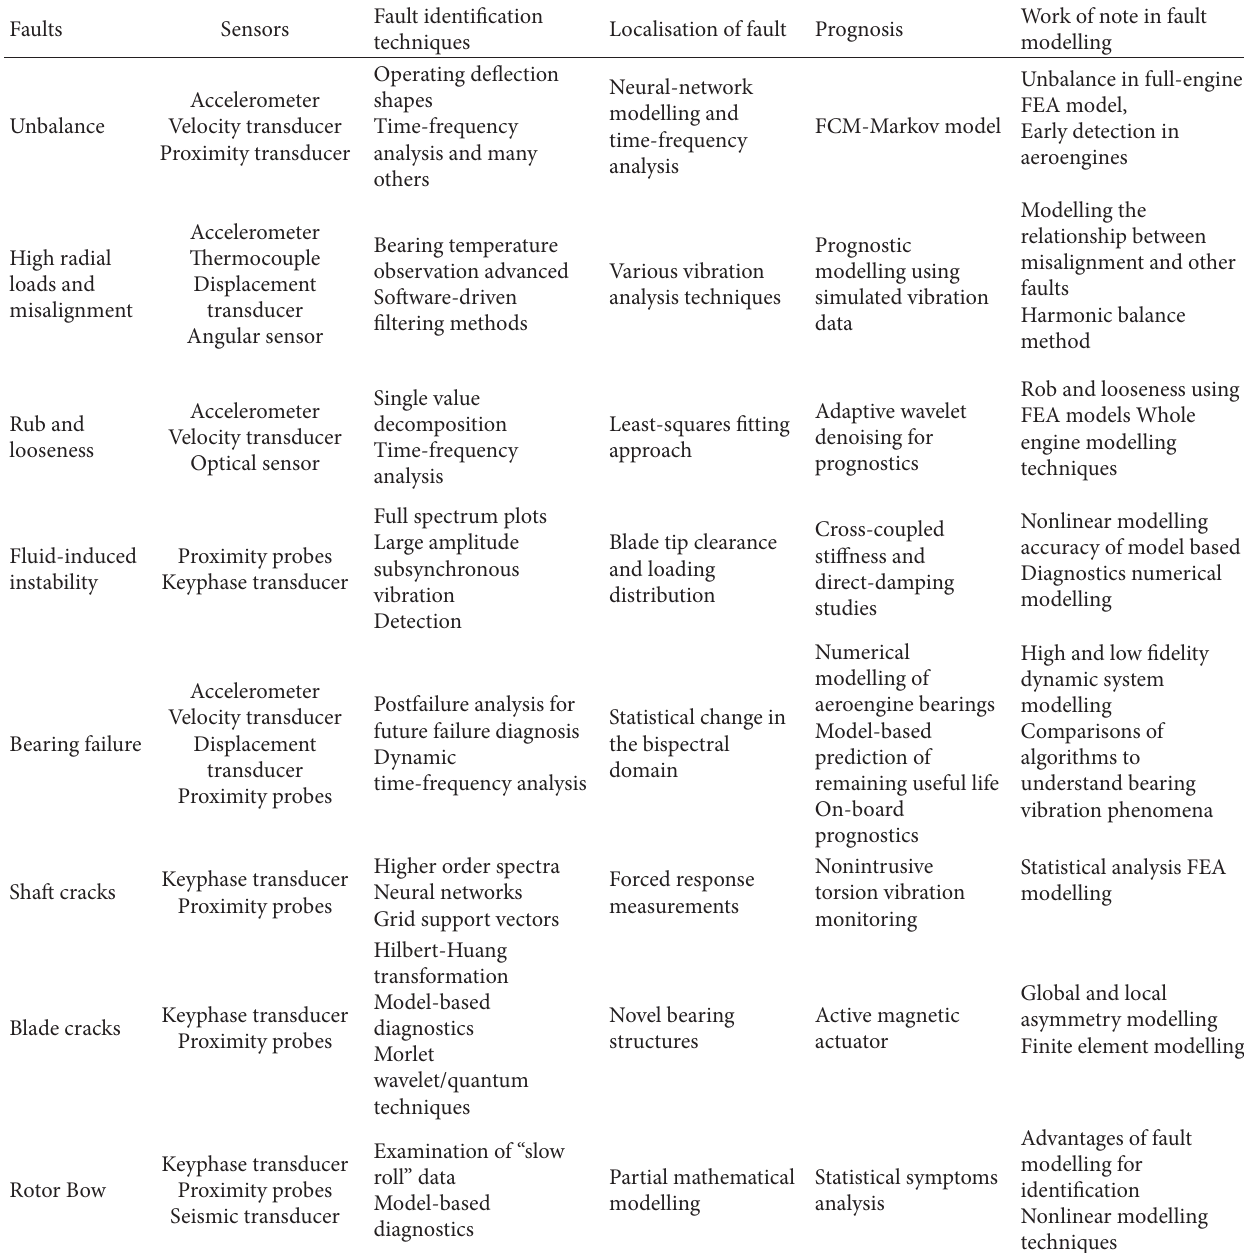
Table 1: Rotordynamic “fault